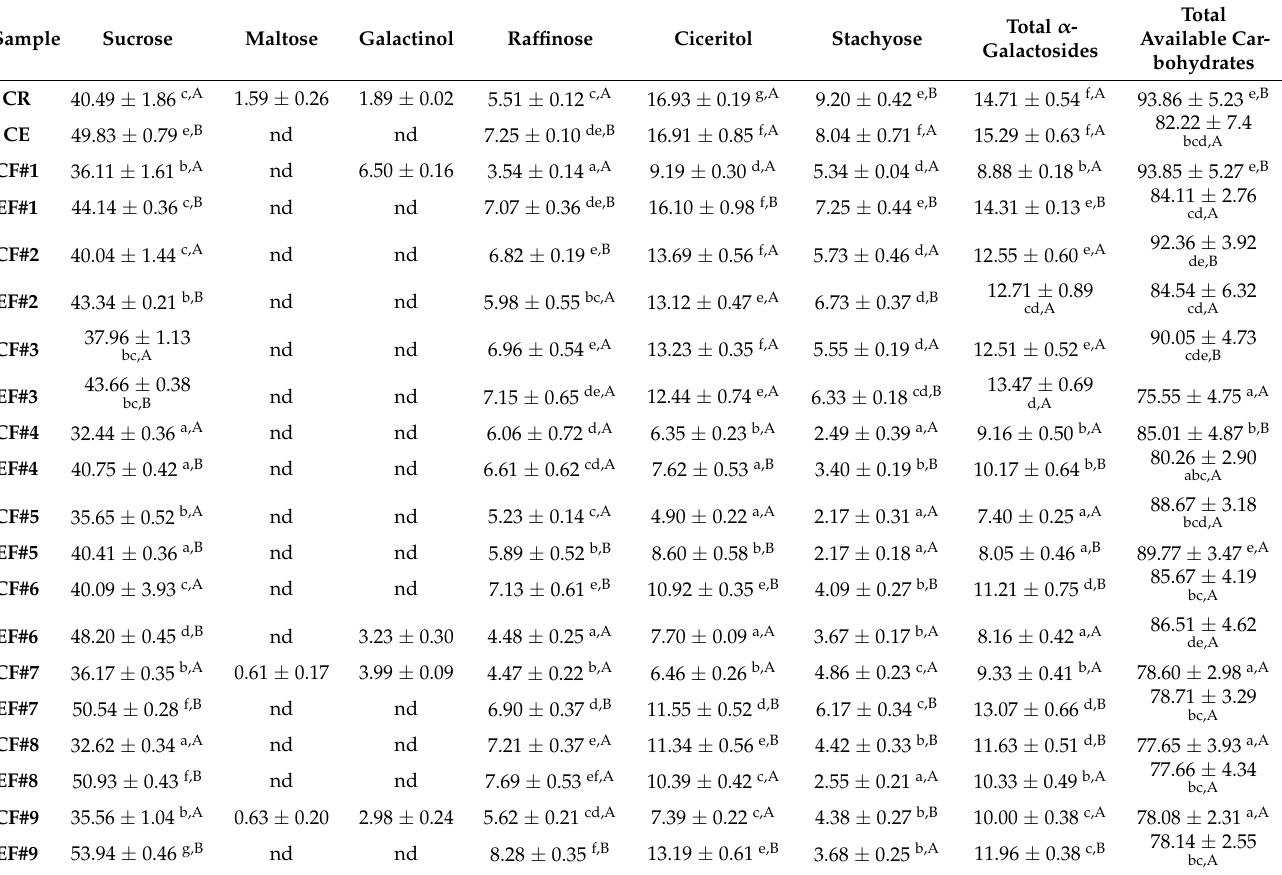
Table 1. The content of soluble sugars (mg/g, fresh weight), α -galactosides (mg/g, fresh weight), and total available carbohydrates (g/100 g, fresh weight) in fortified rice–chickpea flours (raw and extruded) (mean ±